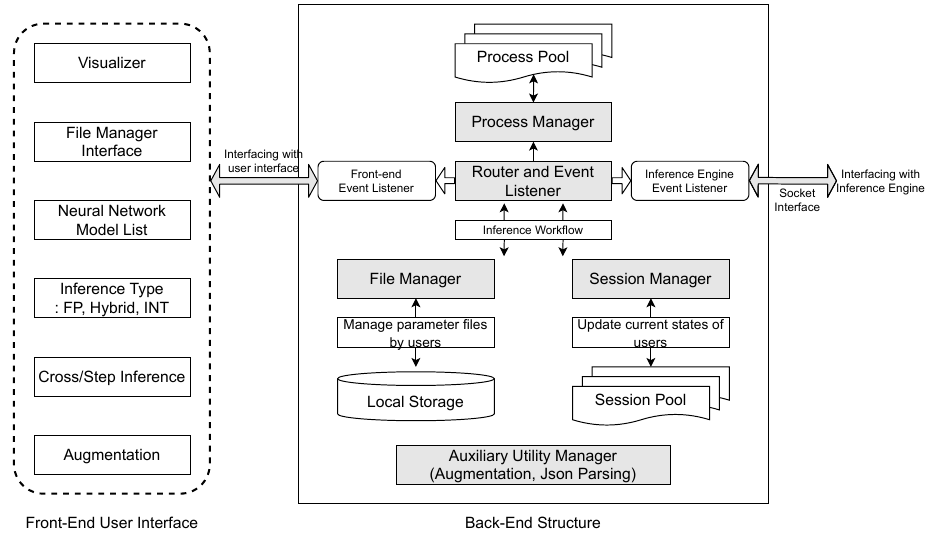
Figure 2. Structure of the GUI platform part composed of the front-end and